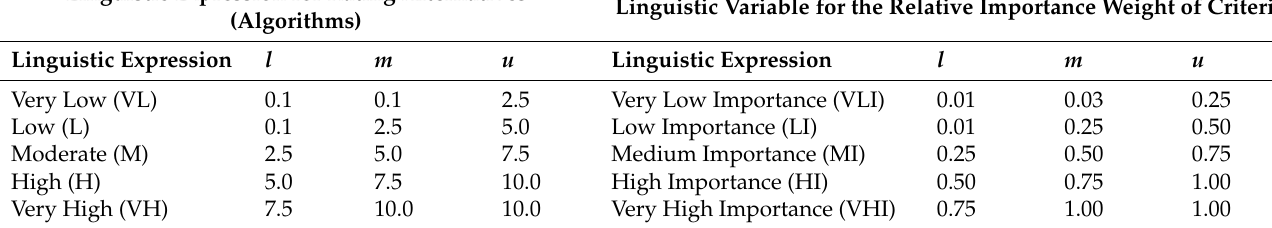
Table 3. Linguistic scales to assess the criteria and alternatives (Chen [97]).